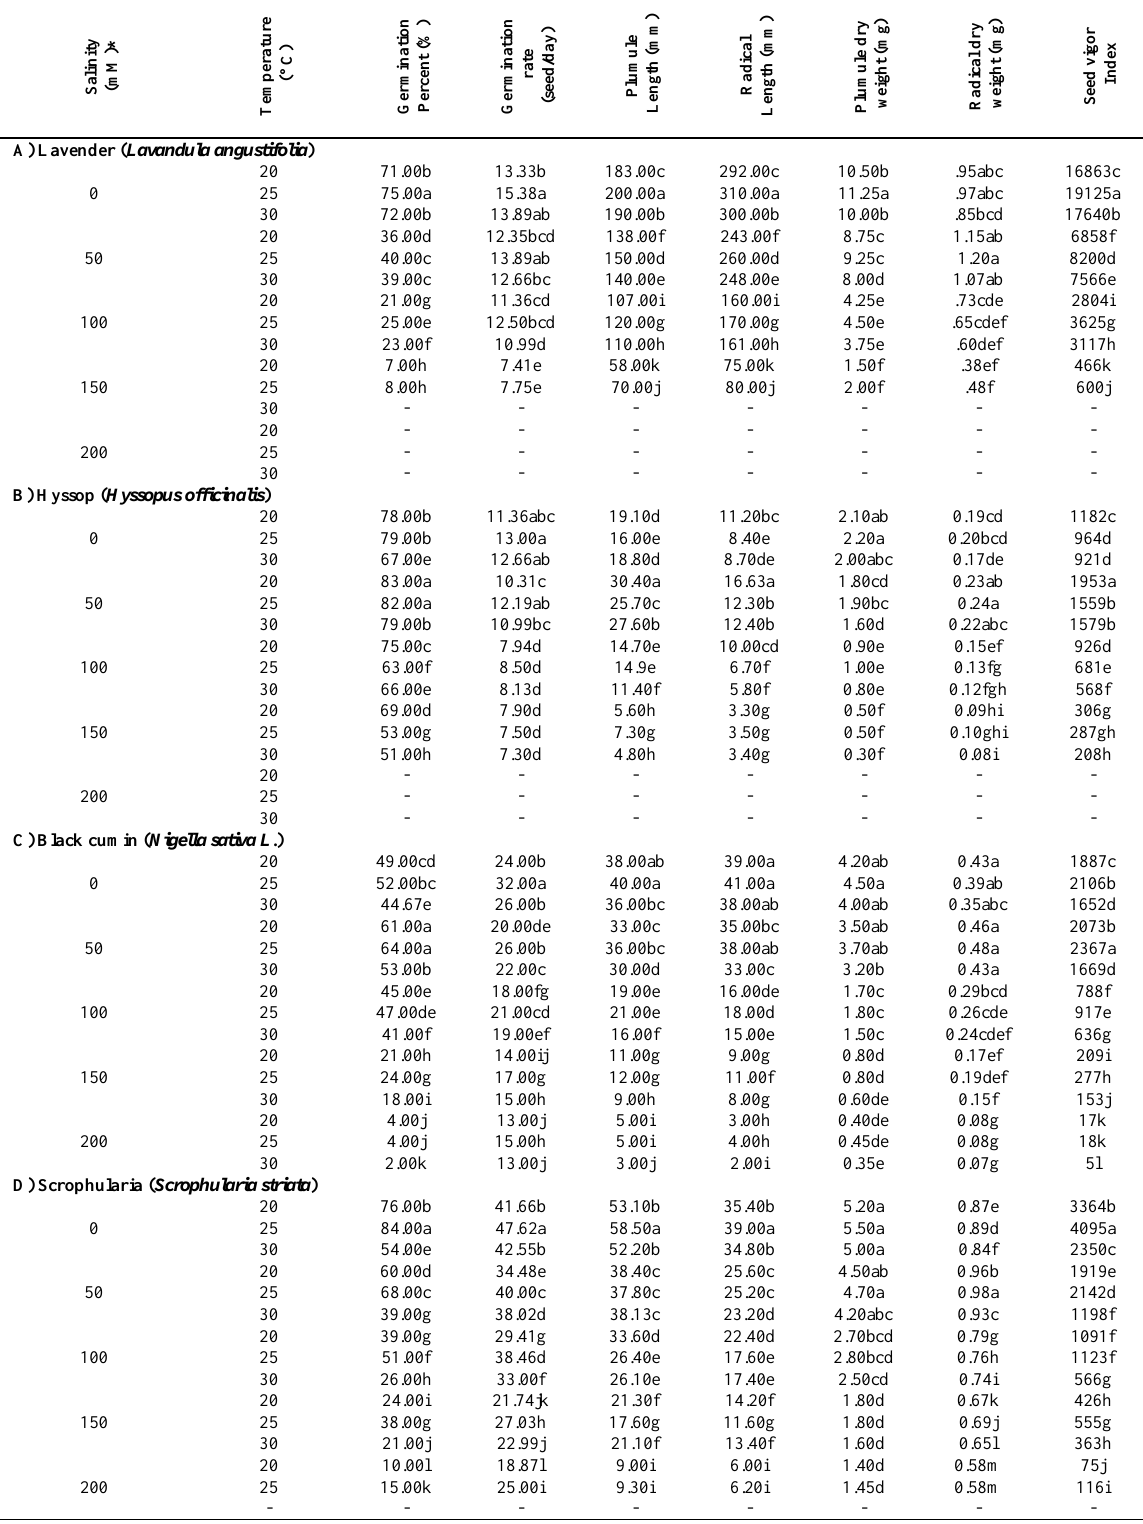
Table 2. Comparison of the mean interaction of salinity levels × temperature on the studied